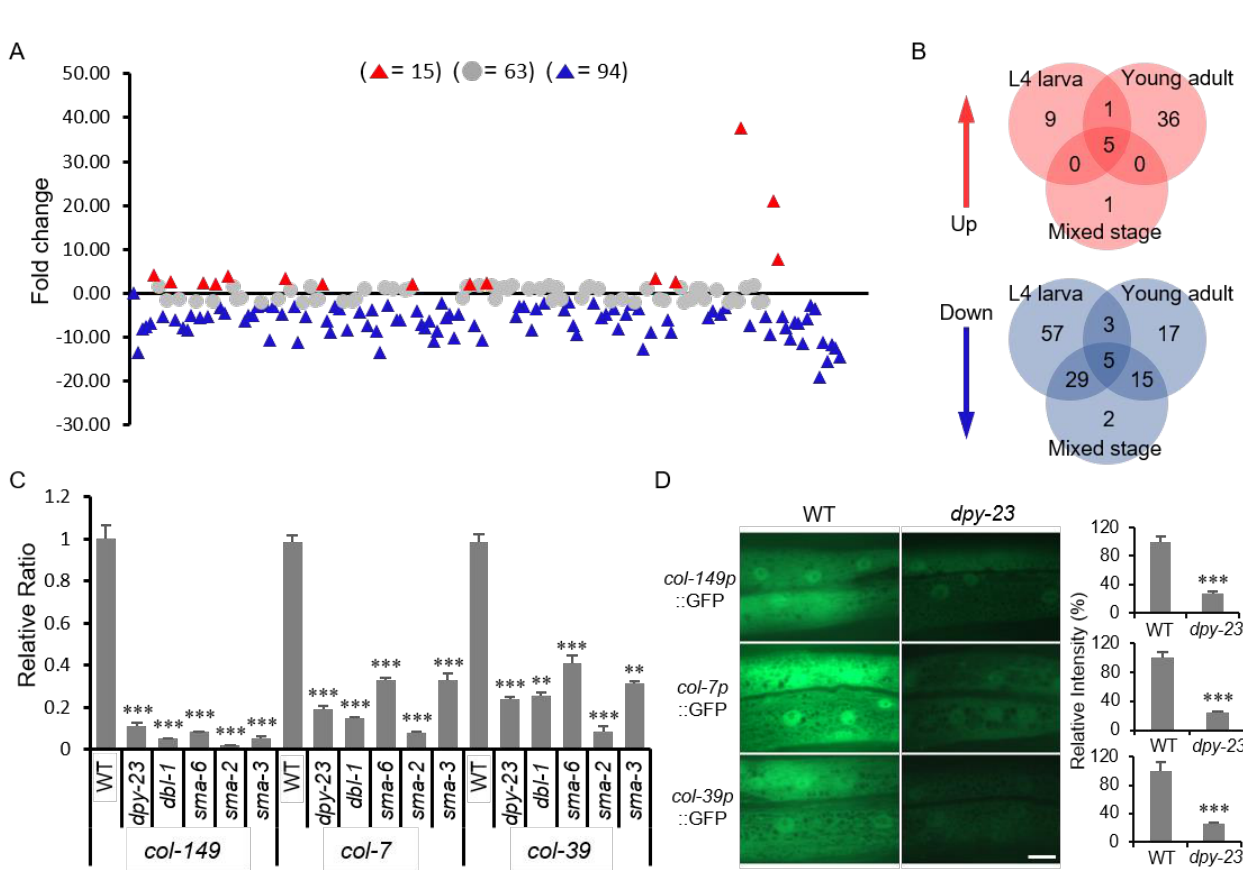
Figure 5. Expression of collagen genes in the dpy‐23 mutant. ( A ) The changes in the expression of 170 collagen genes in the dpy‐23 mutant compared to wild type according to the RNA‐seq results of L4 larvae are shown in the graph. Gray circles indicate collagen with a difference in expression fold change less than 2 (FC < 2), and triangles indicate that FC is more than 2 (FC > 2). Red color indicates an increase in the dpy‐23 mutant, and blue indicates a decrease. The x‐axis is a listing of 170 collagen genes. ( B ) The number of significantly changed collagen genes (FC > 2) in the three RNA‐seq results is shown as a diagram. ( C ) The mRNA expression of three collagen genes including col‐7 , col‐39 and col‐149 was measured by qRT‐PCR in the dpy‐23 and TGF‐β signaling mutants. Error bar = SD. ( D ) The GFP reporter expressed by each collagen promoter was observed to compare dpy‐23 with wild type. The measured GFP intensity was shown in graphs (right panel). Scale bar = 10 μm. Error bar = SEM. ** p < 0.01 and *** p < 0.001 versus WT.